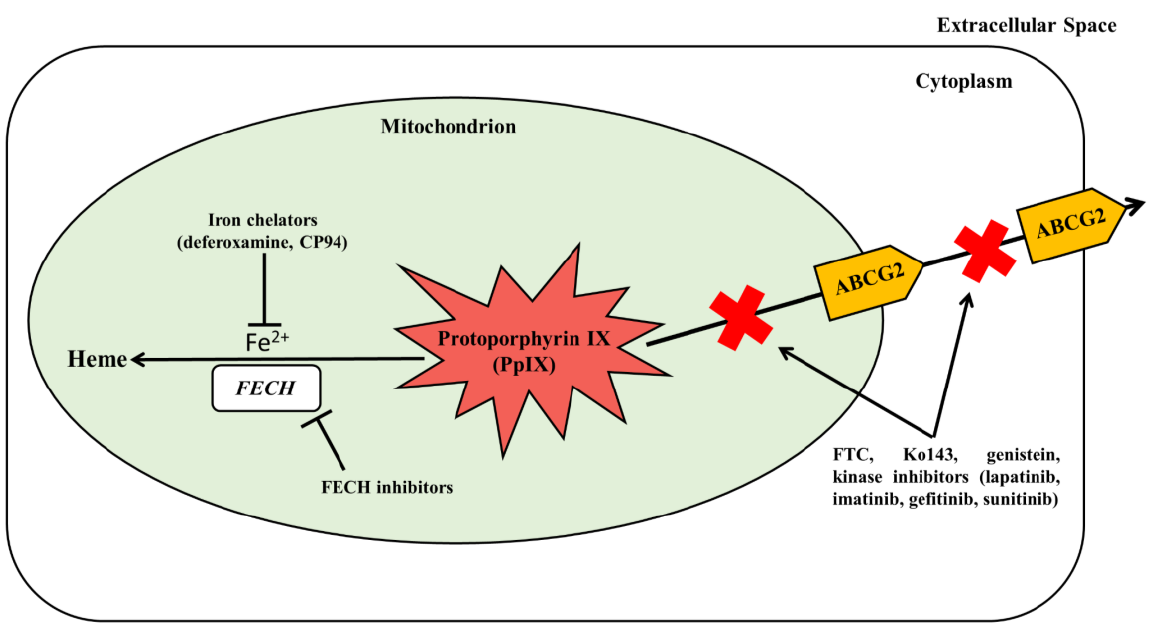
Figure 2. Pharmacological inhibition of PpIX-reducing biological processes for the enhancement of ALA-PpIX fluorescence and PDT. PpIX synthesized in mitochondria can be converted to heme by FECH (using Fe 2+ as another substrate) and effluxed by ABCG2 transporter. Inhibition of these two predominant PpIX-reducing biological processes with chemical inhibitors enhances ALA-induced PpIX.